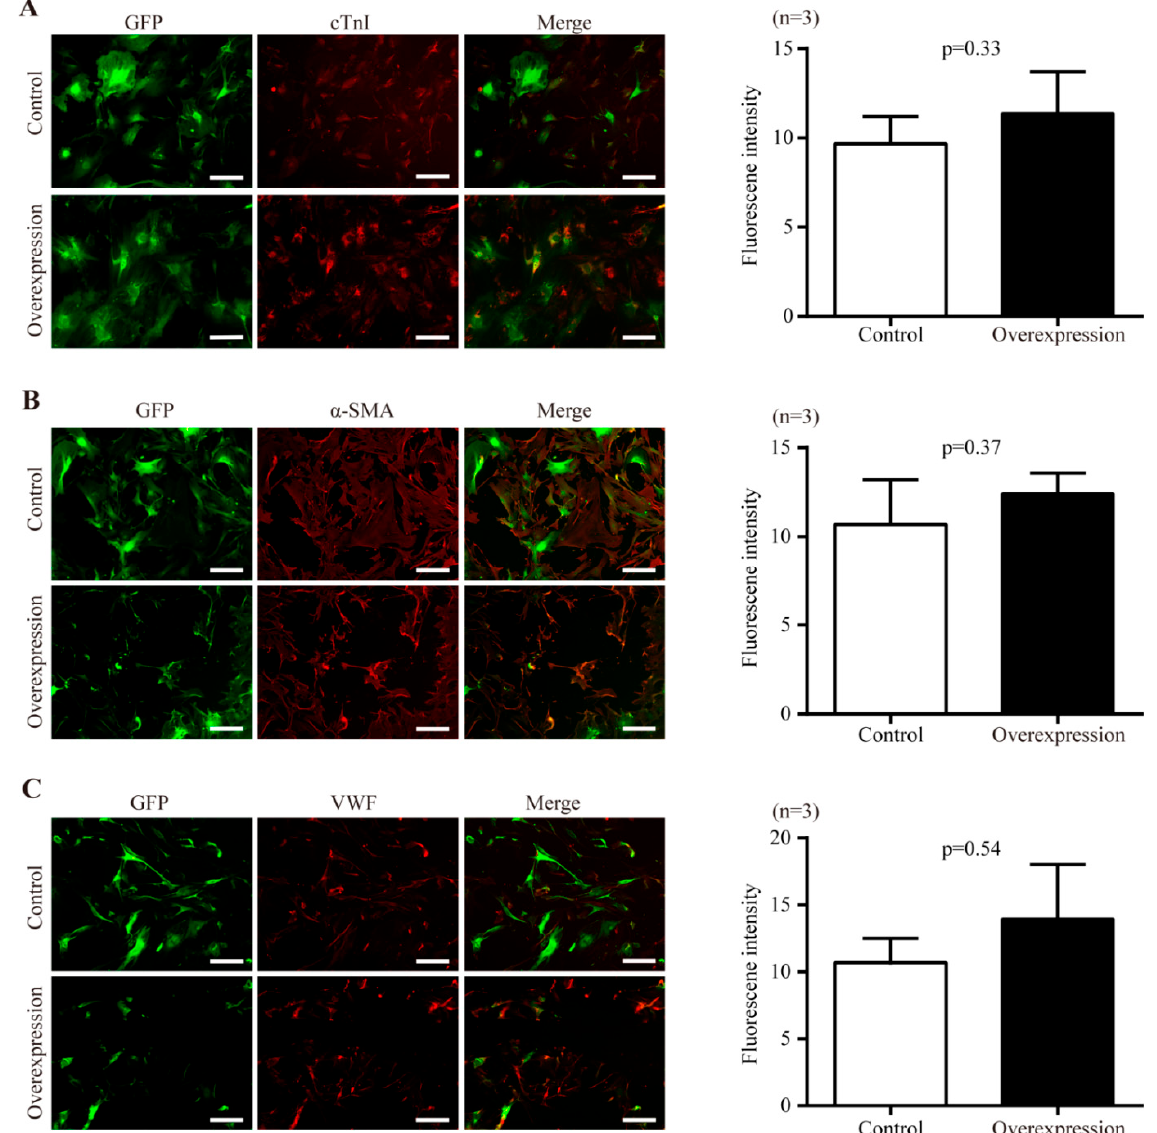
Figure 4. The effect of Nr1d1 overexpression on cell plasticity. ( A – C ) differentiation of young Sca- 1 + CD31 − cells after Nr1d1 overexpression compared to the negative control group. The left panel shows representative immunofluorescence images stained with cardiomyocyte-specific marker cTnI ( A ) (red), smooth muscle marker α -SMA ( B ), and endothelial cell marker VWF ( C ). Sca-1 + CD31 − cells were marked with GFP merged with DyLight ® 550 (red). Each experiment was repeated three times, and each image represents a single result. Scale bars, 50 µ m. The bar graph on the right panel depicts the grayscale values of DyLight ® 550 within the GFP region as determined by ImageJ and Photoshop, with data from three independent experiments ( n = 3) presented as mean SD. A two-tail unpaired t -test was used for statistical analysis, and p < 0.05 was considered